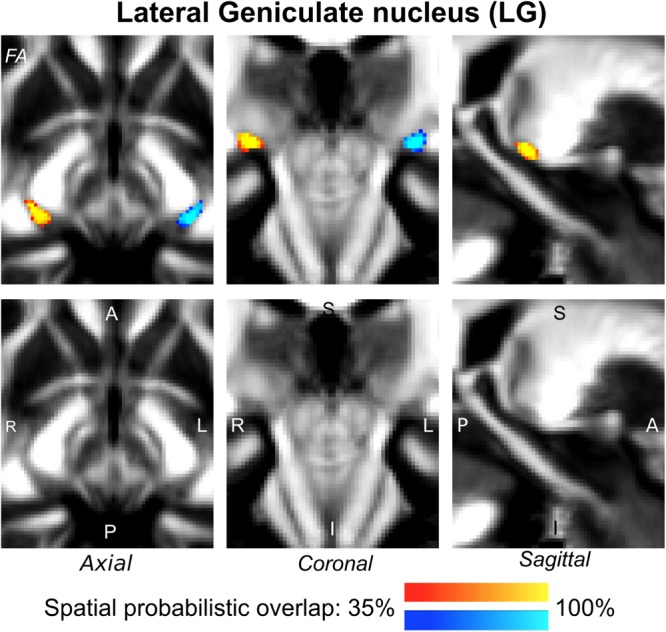
Probabilistic atlas label in MNI space of the LG (left: blue-to-cyan; right: red-to-yellow). The LG was hypointense in diffusion FA MRI; its label is overlaid on the group average FA map. Very good spatial (i.e., up to 100%) agreement of labels across subjects was observed indicating the feasibility of delineating the probabilistic label of this nucleus, which is a thalamic relay for visual and oculo-motor pathways.